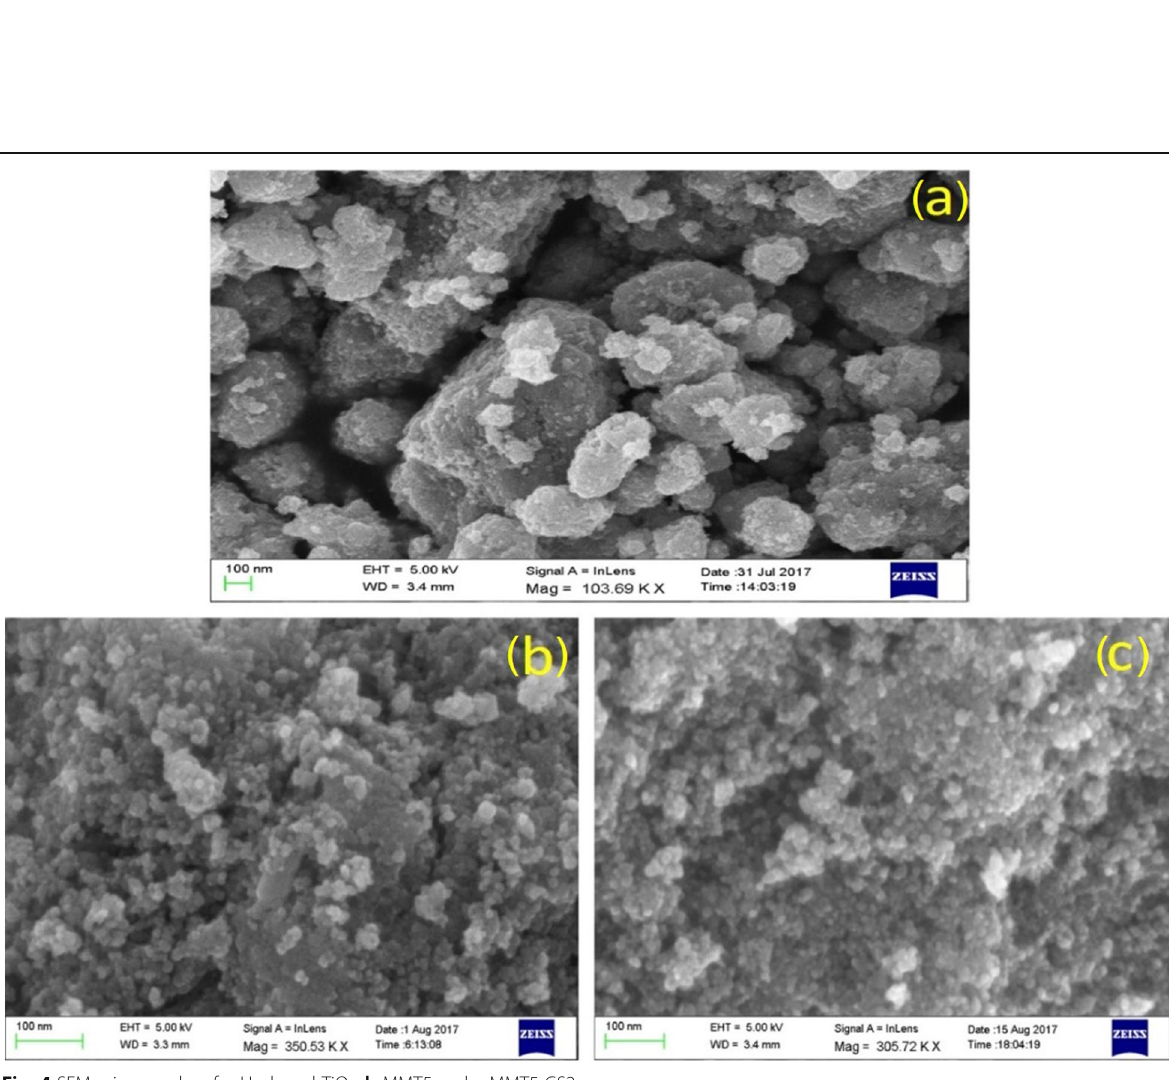
Fig. 4 SEM micrographs of a Undoped TiO 2 , b MMT5 and c